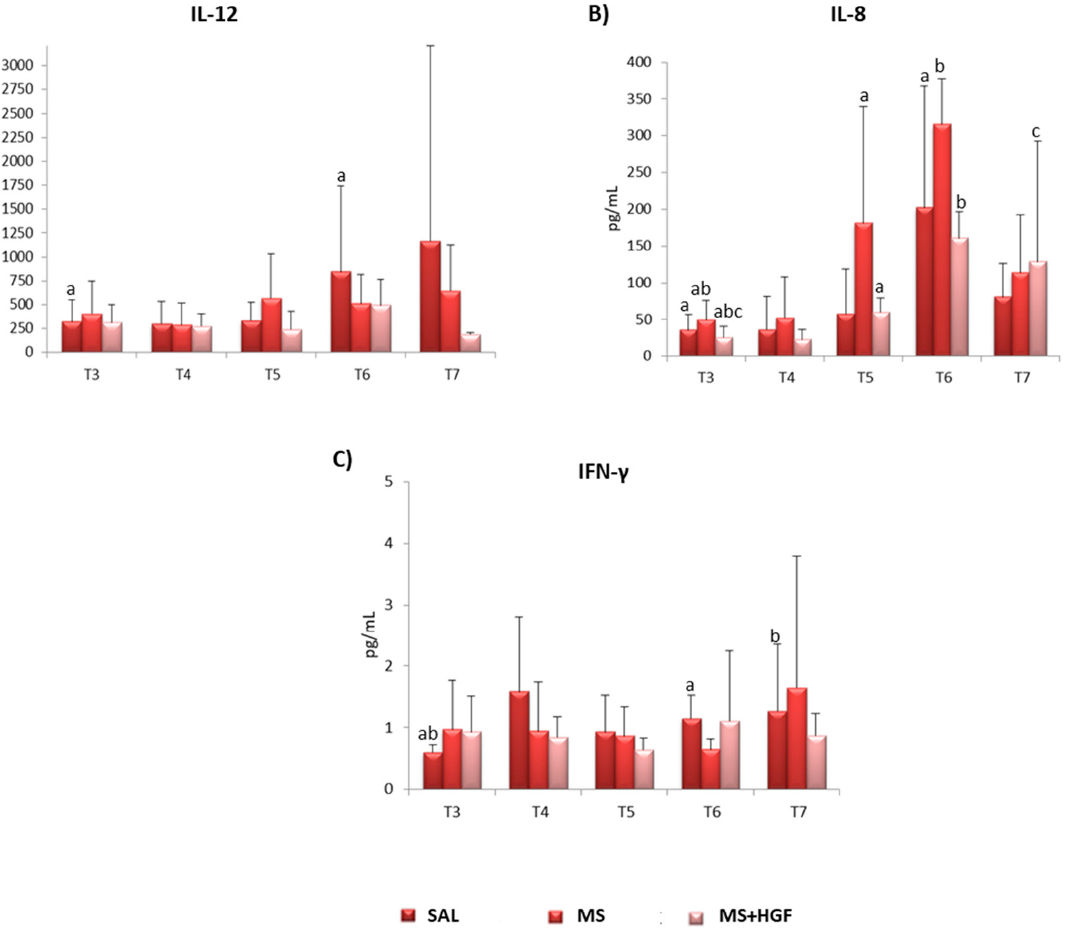
Figure 5. Cytokines: Mean values ± standard deviations of cytokines (pg/mL) from the three groups at T3 (pre-treatment), T4 (post-treatment), T5 (24 h post-treatment), T6 (1 week post-treatment) and T7 (end of study). ( A ) IL-12; ( B ) IL-8; ( C ) IFN- γ . Intragroup differences are determined by a,b,c p < 0.05.